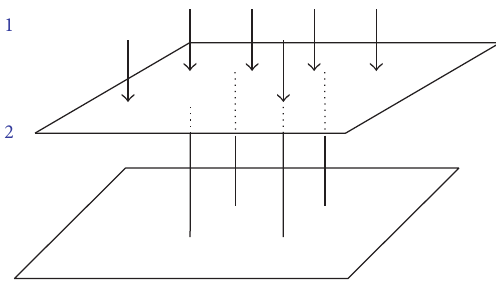
Figure 3: Two plates connected via discrete